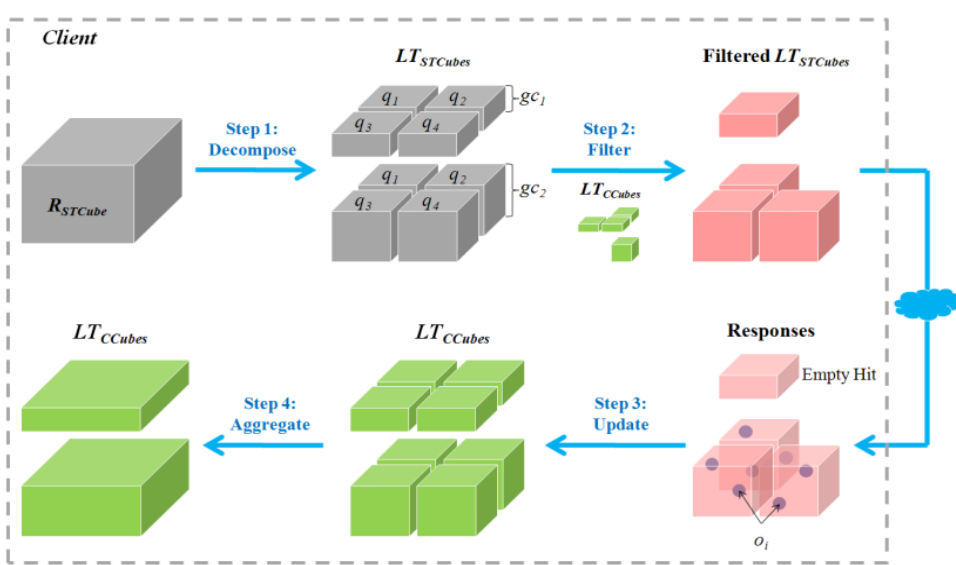
Figure 5. The LOST-Tree